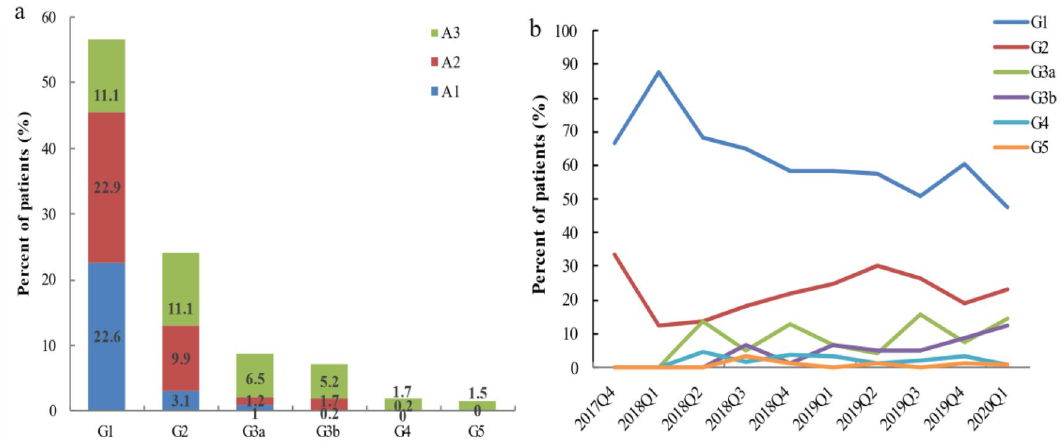
Figure 3. Distribution of GFR and albuminuria in SGLT2i. ( a ) Proportion of patients using SGLT2i in each eGFR and albuminuria category; ( b ) Trends in eGFR status over time in patients using SGLT2i. A1–A3 denote albuminuria category. Albuminuria categories: A1, < 30 mg/g; A2, 30–300 mg/g; A3, > 300 mg/g. G1–G5 denote GFR categories: G1, ≥ 90 ml/min/1.73 m 2 ; G2, 60–89 ml/min/1.73 m 2 ; G3a, 45–59 ml/min/1.73 m 2 ;